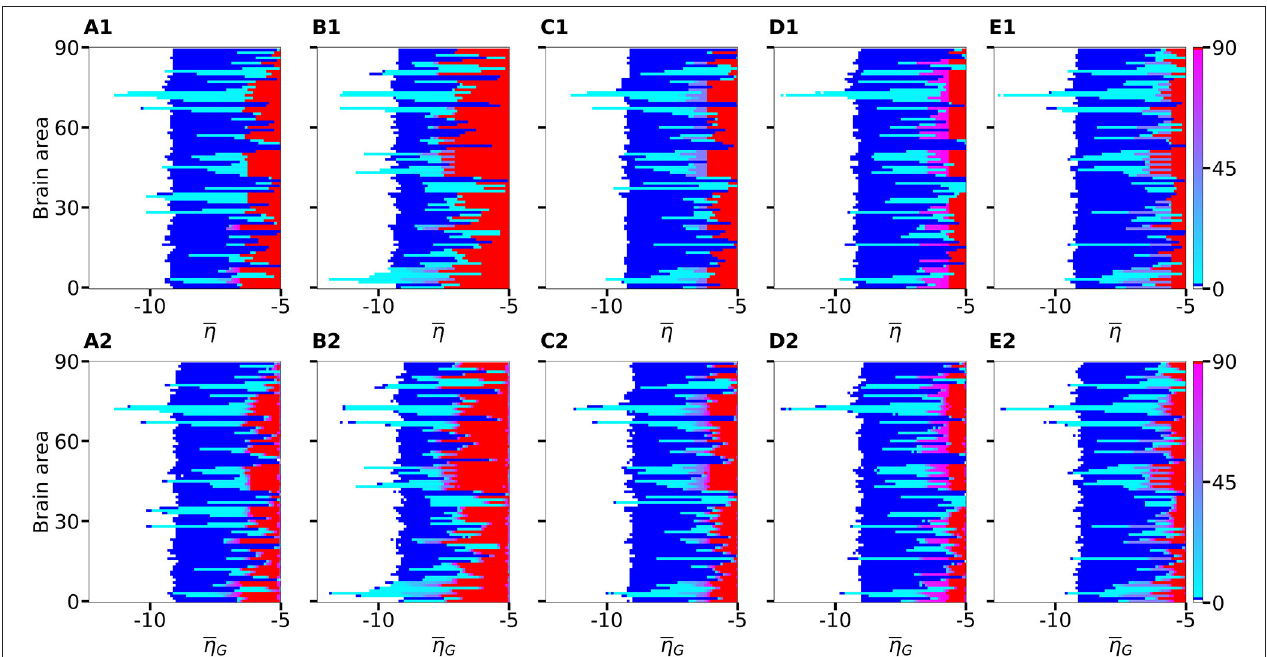
η for five exemplary healthy subject connectomes (A–E) . Color coding is the FIGURE 3 | Number of recruited brain areas as a function of the excitability parameter ¯ following: blue corresponds to the asymptomatic threshold (one area in HA regime); red represents 90 areas in HA regime (generalized threshold); cyan to purple η for panels (A1–E1) . indicate intermediate recruitment values, white marks no recruitment. When performing a vertical cut, all nodes are characterized by the same ¯ η G represents the mean value of a Gaussian distribution with standard deviation 0.1. Therefore, when perturbing one brain area at On the contrary, in panels (A2–E2) , ¯ a time, excitabilities are distributed and not uniform in the latter case; the results are averaged over 10 repetitions with different Gaussian excitability distributions.